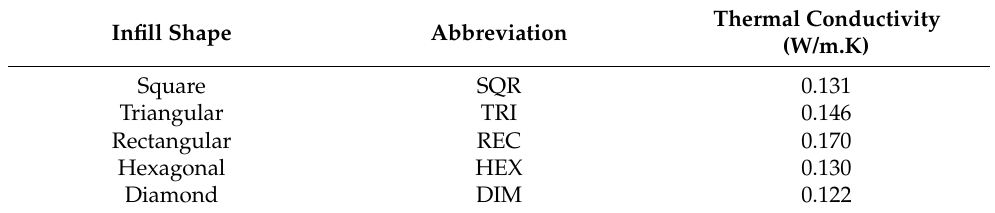
Table 2. Thermal conductivities of the 3DPC wall unit cell models with different infill